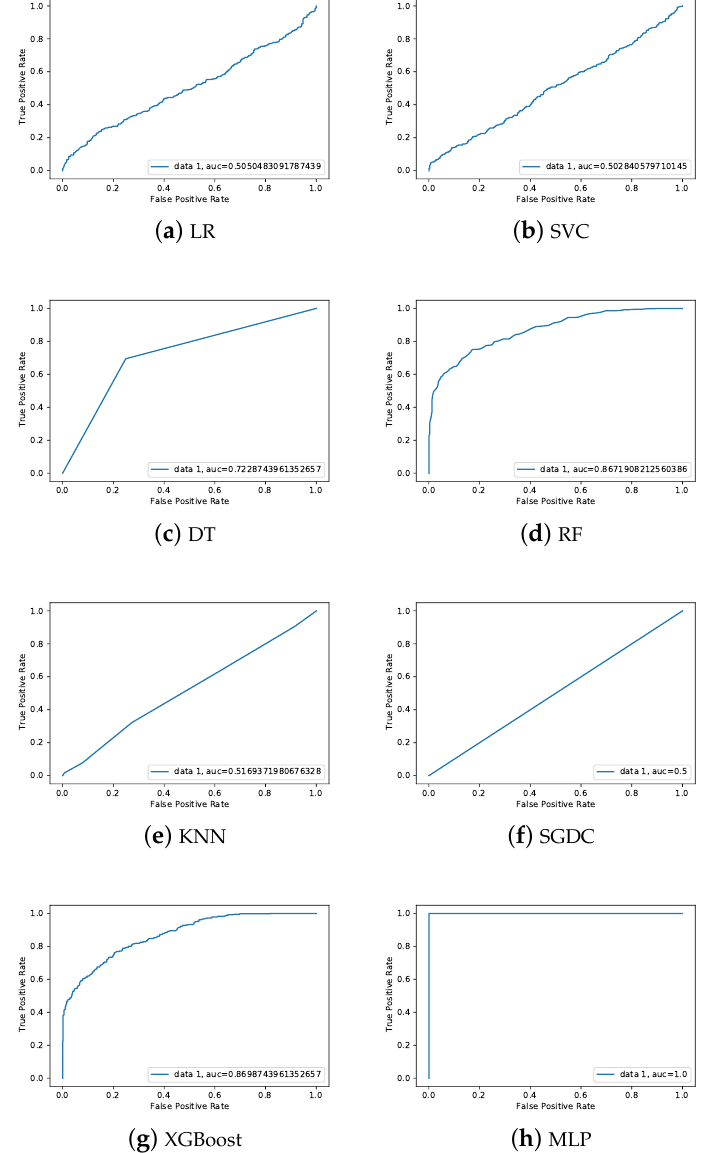
Figure 8. AUC curve of